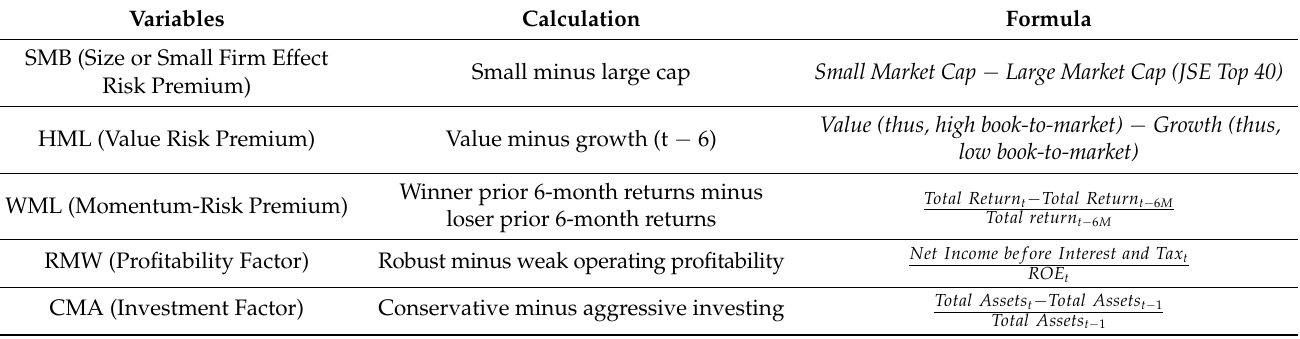
Table 1. Summary of the